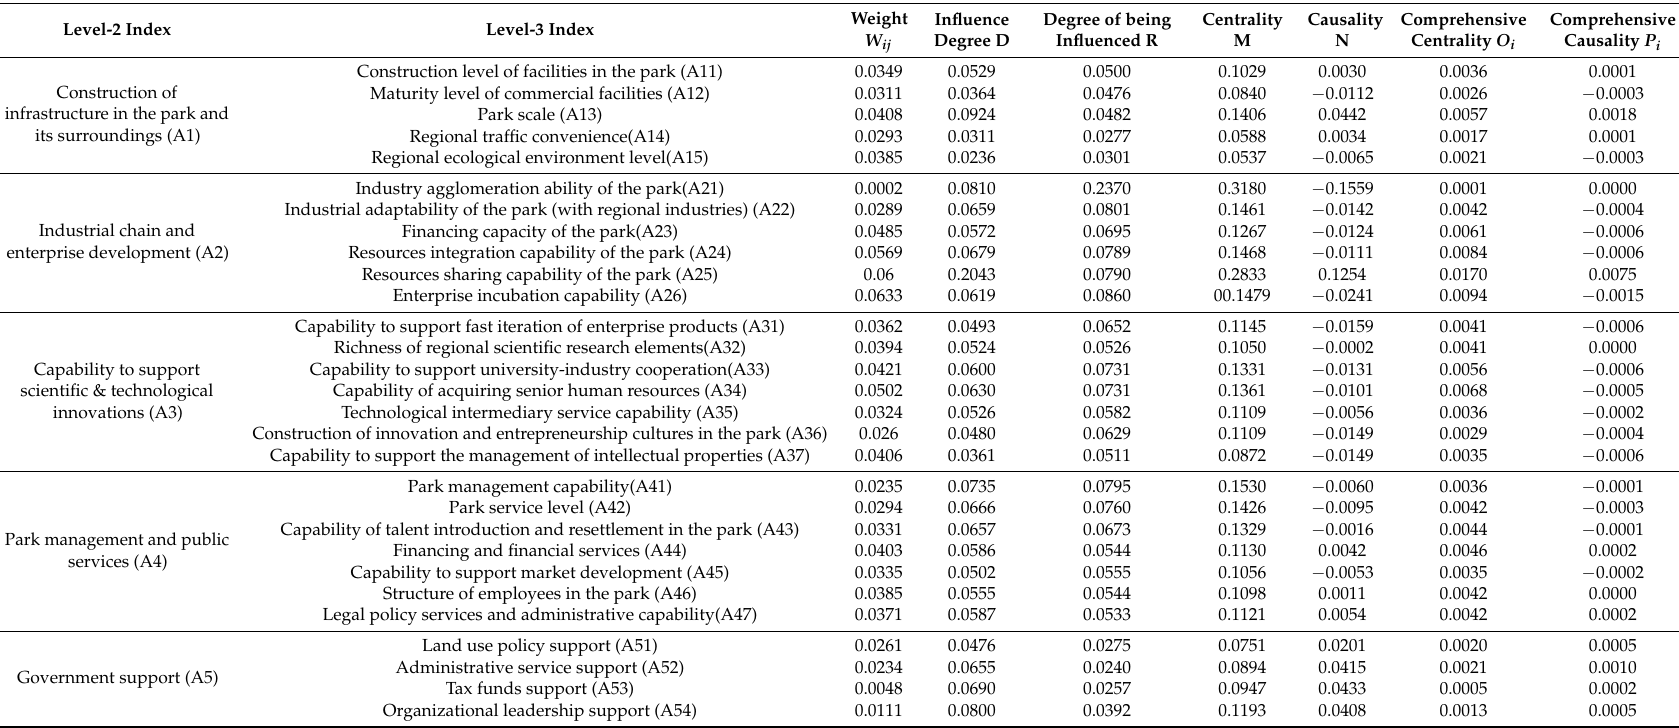
Table 8. Comprehensive influence